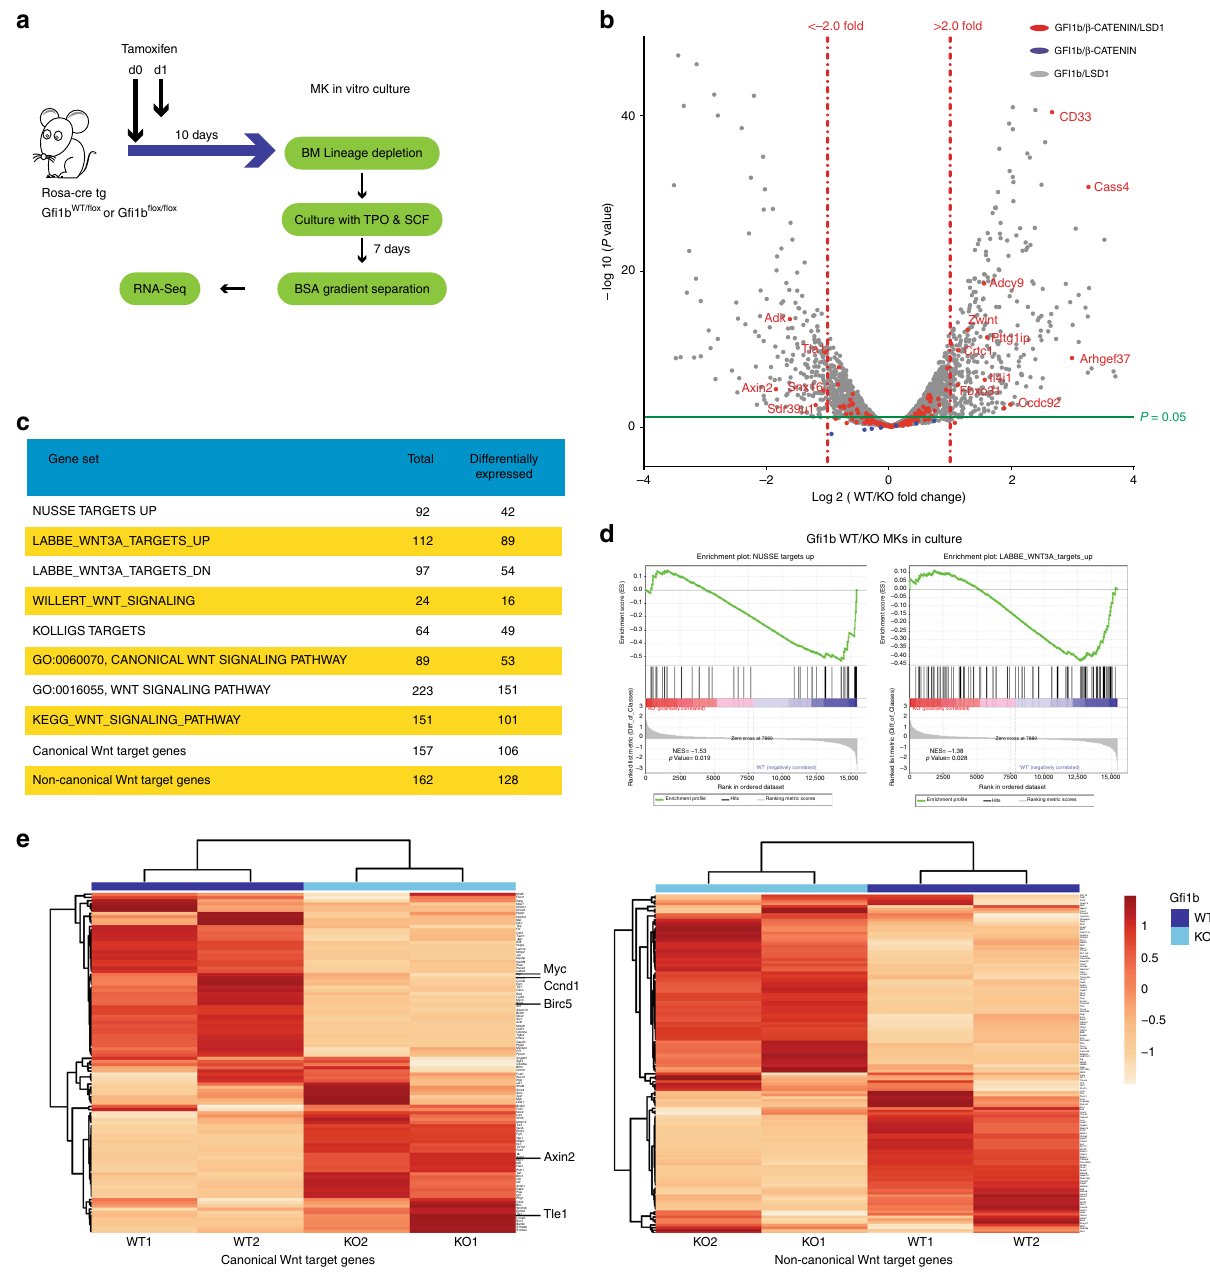
Fig. 7 Canonical and non-canonical Wnt target genes are deregulated in G fi 1b KO MK in vitro. a G fi 1b WT/KO mice were taken to obtain lineage depleted BM cells, n = 2 GFI1b WT and GFI1B KO mice. Cells were taken into culture in the presence of TPO and SCF for 7 days and MK were separated using BSA gradient followed by RNA-seq analysis. b Volcano plot of expression fold change (KO/WT) over the P value of differences between WT and KO. Vertical dashed lines show the threshold of two-fold change in expression in KO samples compared to WT. The color code shows the co-occupation of promotor by indicated factors as seen in ChIP-seq data from K562 cells. c , d Gene set enrichment analysis (GSEA) of RNA-seq data from the sorted cells using published Wnt related gene sets and two new sets of Wnt target genes pooled from published data. e Unsupervised clustering of RNA-seq data using indicated gene